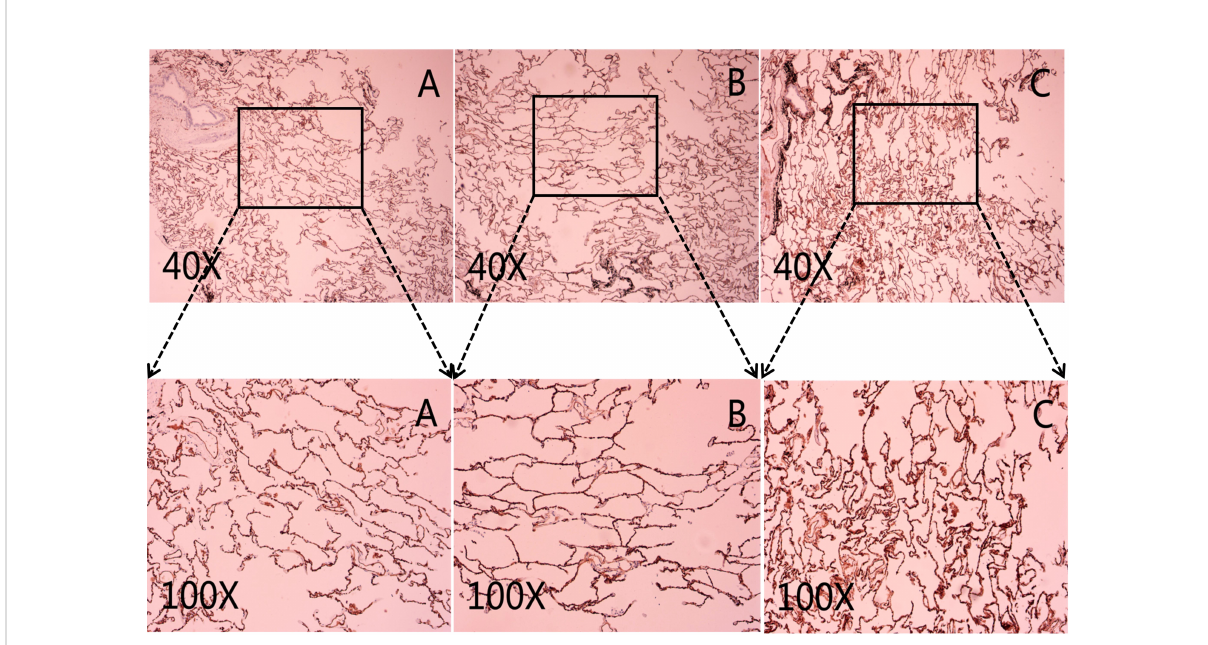
FIGURE 2 Representative micrograph in neighboring normal lung tissues. (A) Representative micrograph of CD31 expression in neighboring normal lung tissues. (B) Representative micrograph of CD34 expression in neighboring normal lung tissues. (C) Representative micrograph of CD105 expression in neighboring normal lung tissues. Black arrows point to the clearly stained neovascularization.